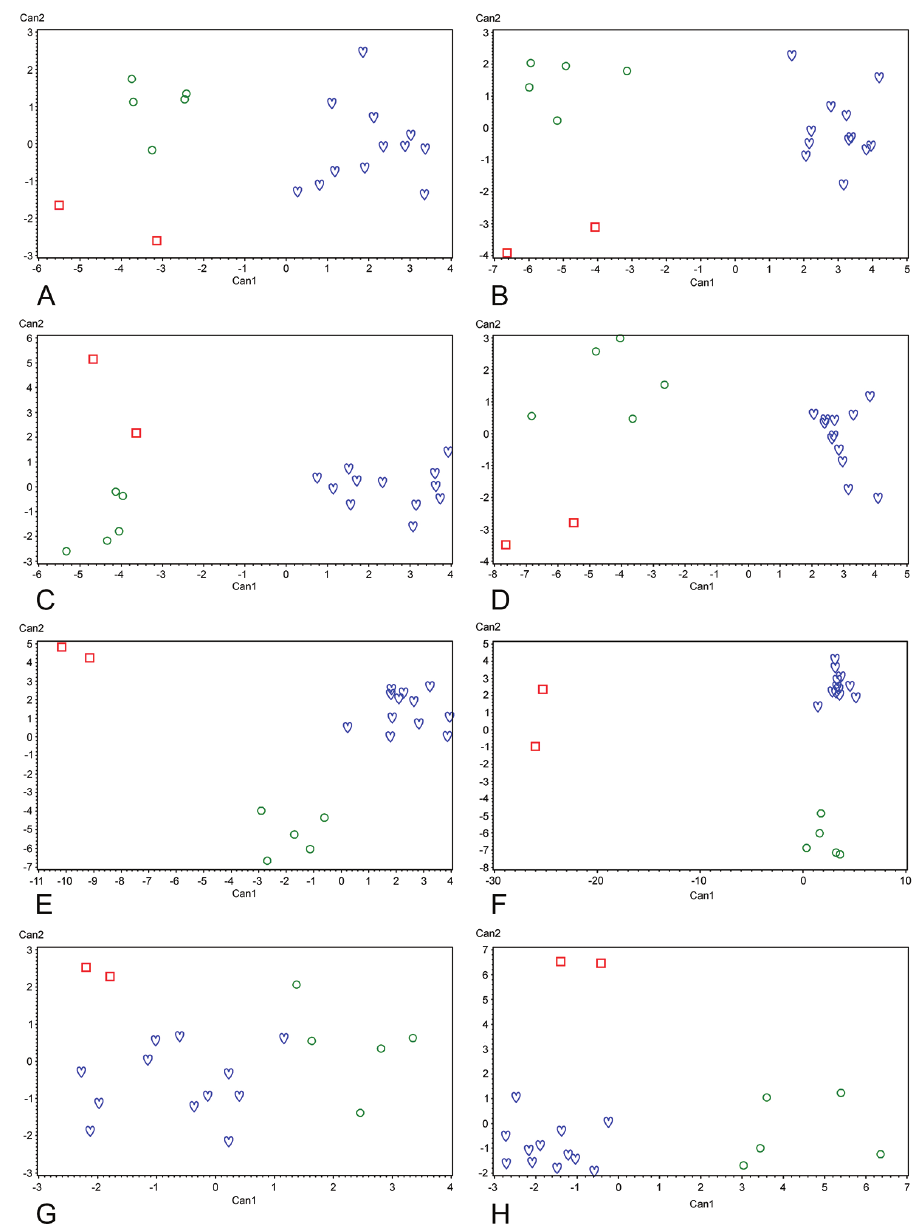
Figure 8. Eight canonical discriminant analyses (CDA 1–8) of three Lasiochernes species ( L . cretonatus : green circles; L . jonicus : red squares; L . pilosus : blue hearts) based on 19 adult specimens and morphologi- cal characters measured/scored on eight different parts of the body (A–G): A CDA 1: Carapace B CDA 2: Chelicera C CDA 3: Palp (without chela) D CDA 4: Chela E CDA 5: Leg I F CDA 6: Leg IV G CDA 7: Tergites H CDA 8: Sternites. For total canonical structure and the lists of characters measured/scored on each body parts, see Supplementary file